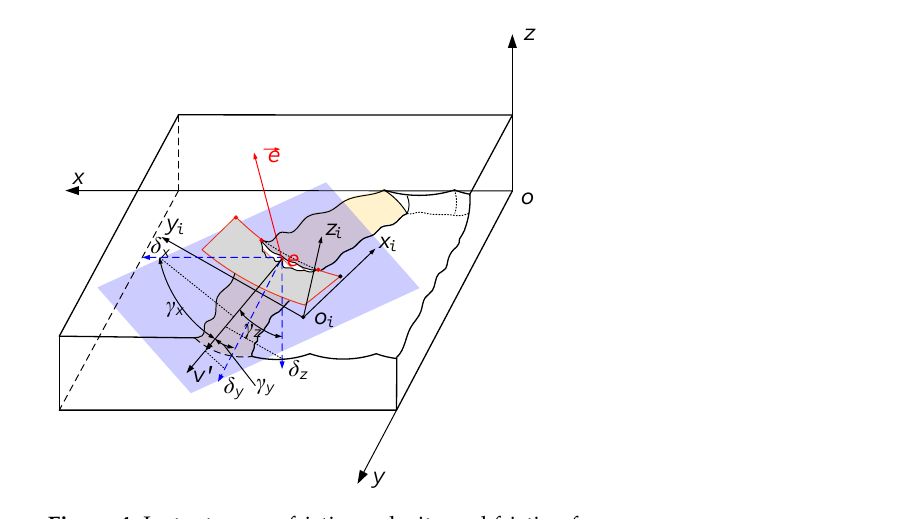
Figure 4. Instantaneous friction velocity and friction force.